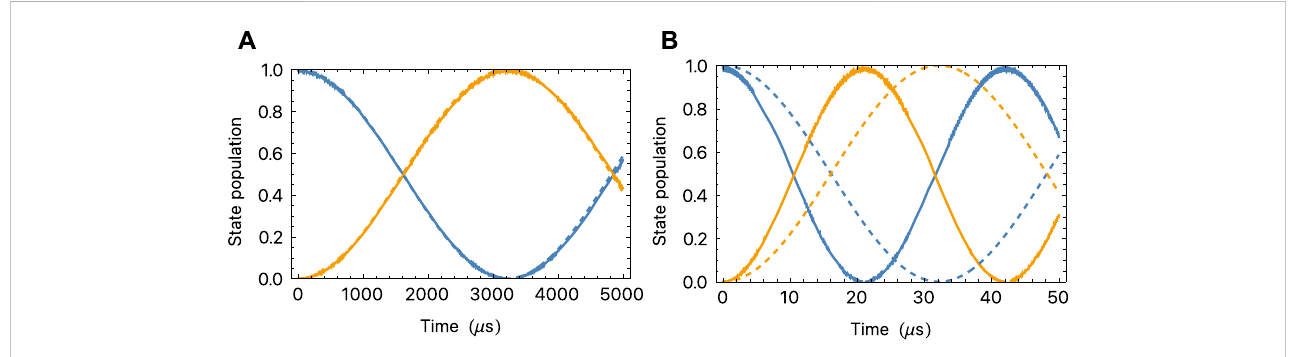
FIGURE 6 Dynamics of the six-level system shown in Figure 5. Populations of the states M F = 5/2 (blue) and M F = − 5/2 (orange). Solid lines: solutions of the Schrödinger equation for the Hamiltonian given in Eq. 9. Dashed lines: effective two-level model, Eq. 10. Parameters are: (A) Ω 1 = Ω 2 = Ω 3 = 2 π × 6 MHz, Δ 1 = Δ π × 100 MHz. (B) Same as (A) except Δ π × 10 2 = 2 2 = 2